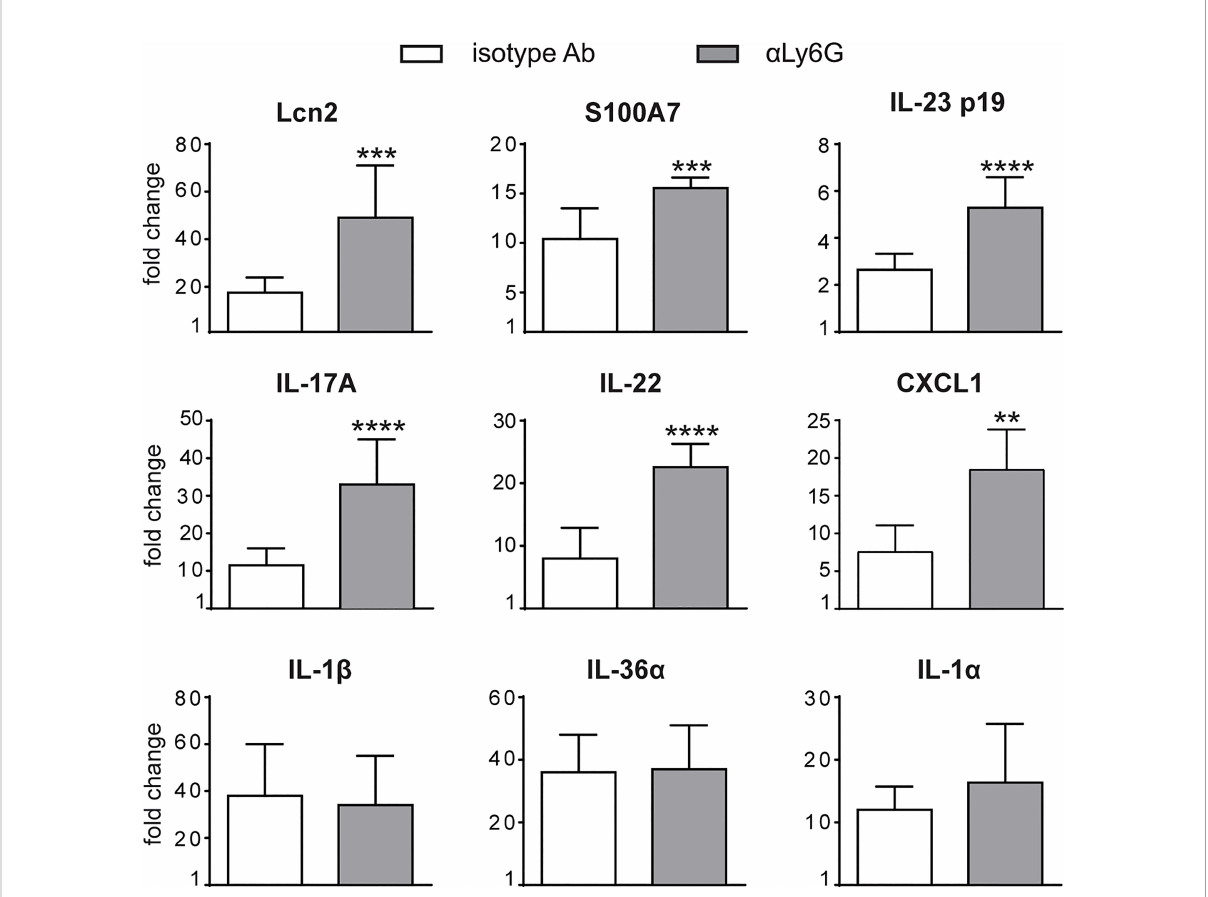
FIGURE 2 Gene-expression analysis of in fl ammatory molecules in the skin of IMQ-treated control or neutrophil-depleted mice. The dorsal skin of mice was topically treated with IMQ-containing cream (Aldara ® ) or vaseline for 6 consecutive days. Mice were injected with the depleting antibody a Ly6G or isotype control Ab. Total skin RNA was extracted and reverse transcribed. mRNA expression of the indicated genes for IMQ-treated control or neutrophil-depleted mice is displayed as fold change of MNE units (after RPL32 normalization) over vaseline-treated control. Data are pooled from 2 separate experiments and are expressed as means ± SD (n = 8-12 mice). Statistical differences of IMQ-treated control vs . neutrophil-depleted mice (*) are reported. *** P ≤ 0.001; ** P ≤ 0.01; **** P ≤ 0.0001 by t-